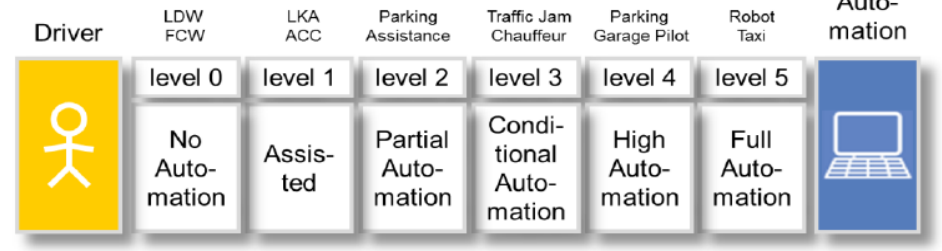
Table 8. Scenario classification—level.